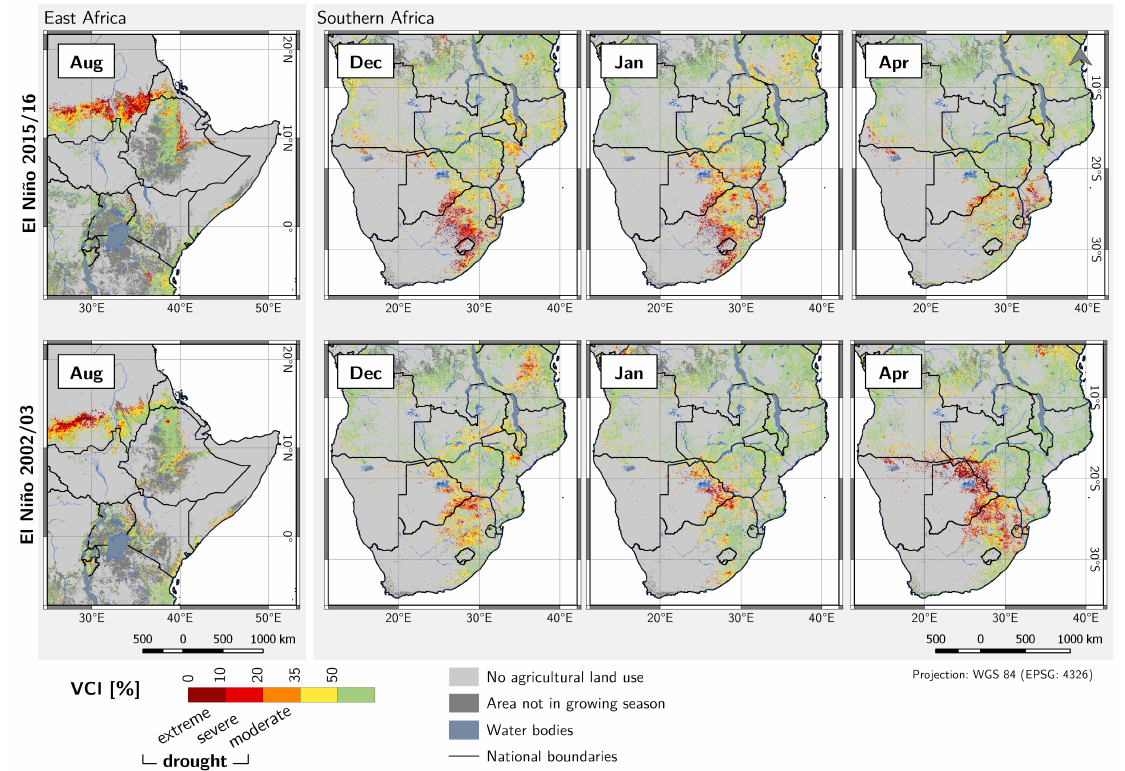
Figure 9. Drought dynamics based on monthly means of VCI during El Niño events 2015/2016 (strong) and 2002/2003 (moderate) for August (Aug.), December (Dec.), January (Jan.) and April (Apr.) in East and southern